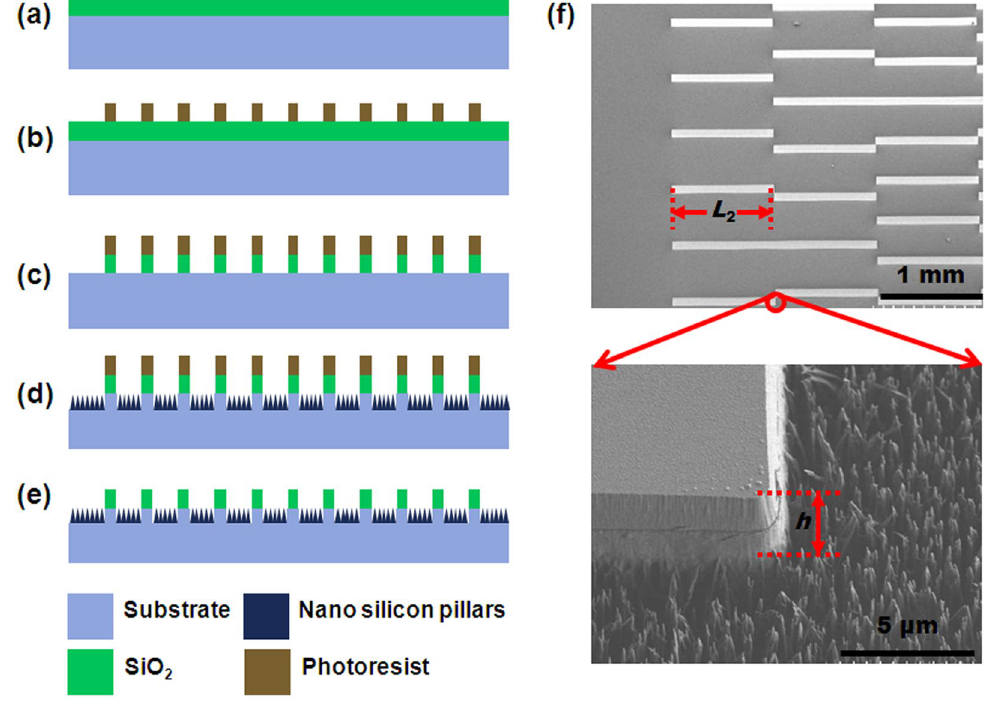
Figure 1. Fabrication process of wettability gradient surface. ( a ) Oxidation. ( b ) Patterns fabrication though UV lithography. ( c ) Silicon oxide etching via RIE. ( d ) Silicon etching via deep RIE. ( e ) Removal of photoresist. ( f ) SEM images of the patterned wettability gradient surface, SiO 2 stripe and the silicon nanopillars